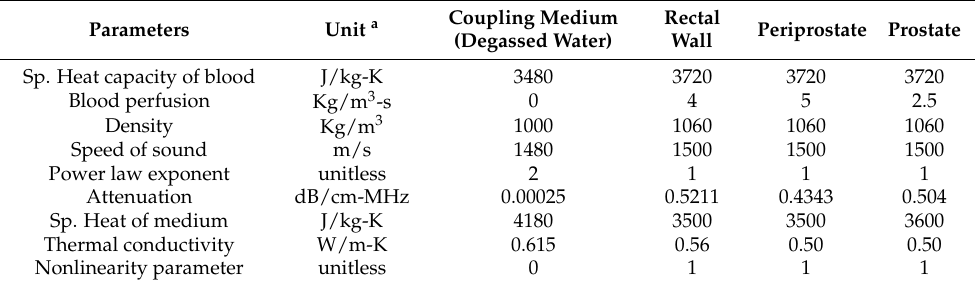
Table 1. Tissue properties used for degassed water, rectal wall, preiprostate, and prostate media [39–42].